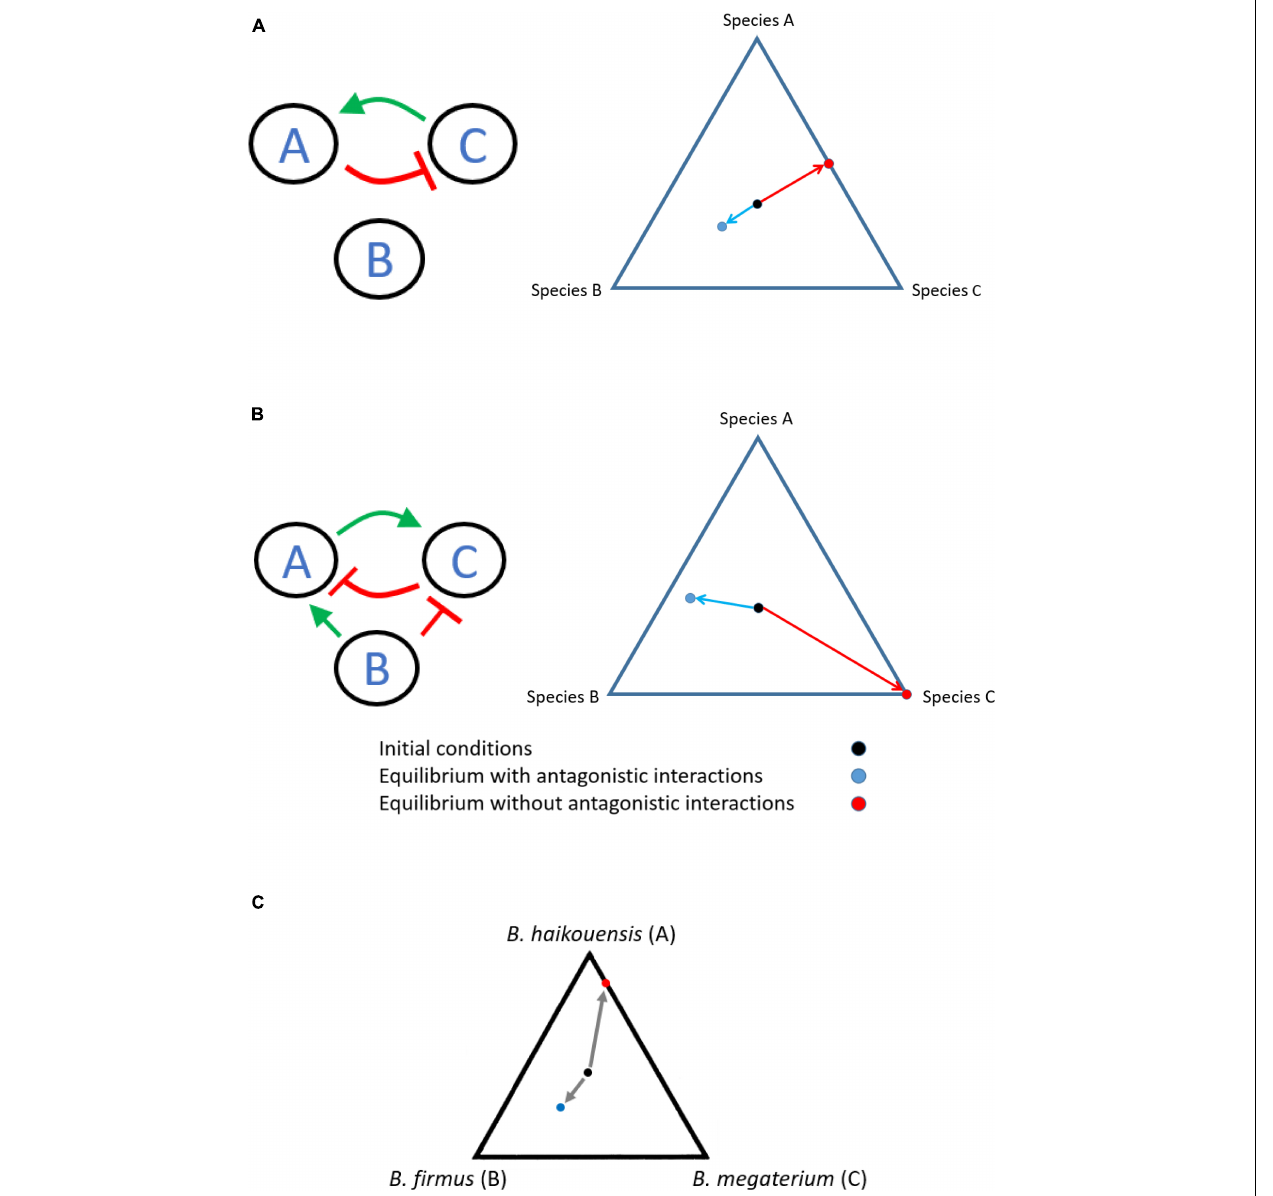
FIGURE 6 | Possible role of antagonistic interactions in maintaining species diversity. Loss of antagonistic interactions in two different topologies (A,B) in a community leads to loss of diversity. (C) Antagonistic interaction provides stability to a three-species system. Black circle represents the starting frequencies of the three species. Blue circle represents the steady state between the three species when cooperative and antagonistic interactions between A and C were present. Red circle represents the steady state when only cooperative interaction from C to A was present; and the antagonistic interaction was absent from the system. Steady state in this experiment represents serial culturing the growth media yielded no change in the frequencies of the species present. The experiment was performed in triplicate, and the average of the three experiments is shown. The standard deviation in the frequencies for the case with all interactions present was < 5% of frequency. Species B was eliminated in all three runs of the experiment, when antagonistic interaction was